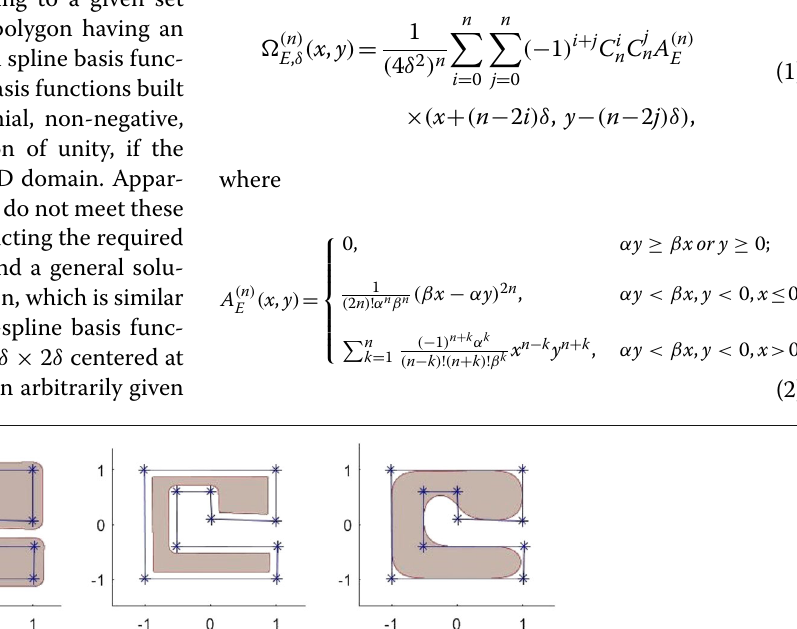
Fig. 4 The left two figures show the areas defined by the distance function to the polygon boundary. The right figure shows the area defined by the implicit spline functions built from the given polygon. As it can be seen from the figure, the solid area modeled by using the 2D implicit spline technique behaves more like traditional parametric splines